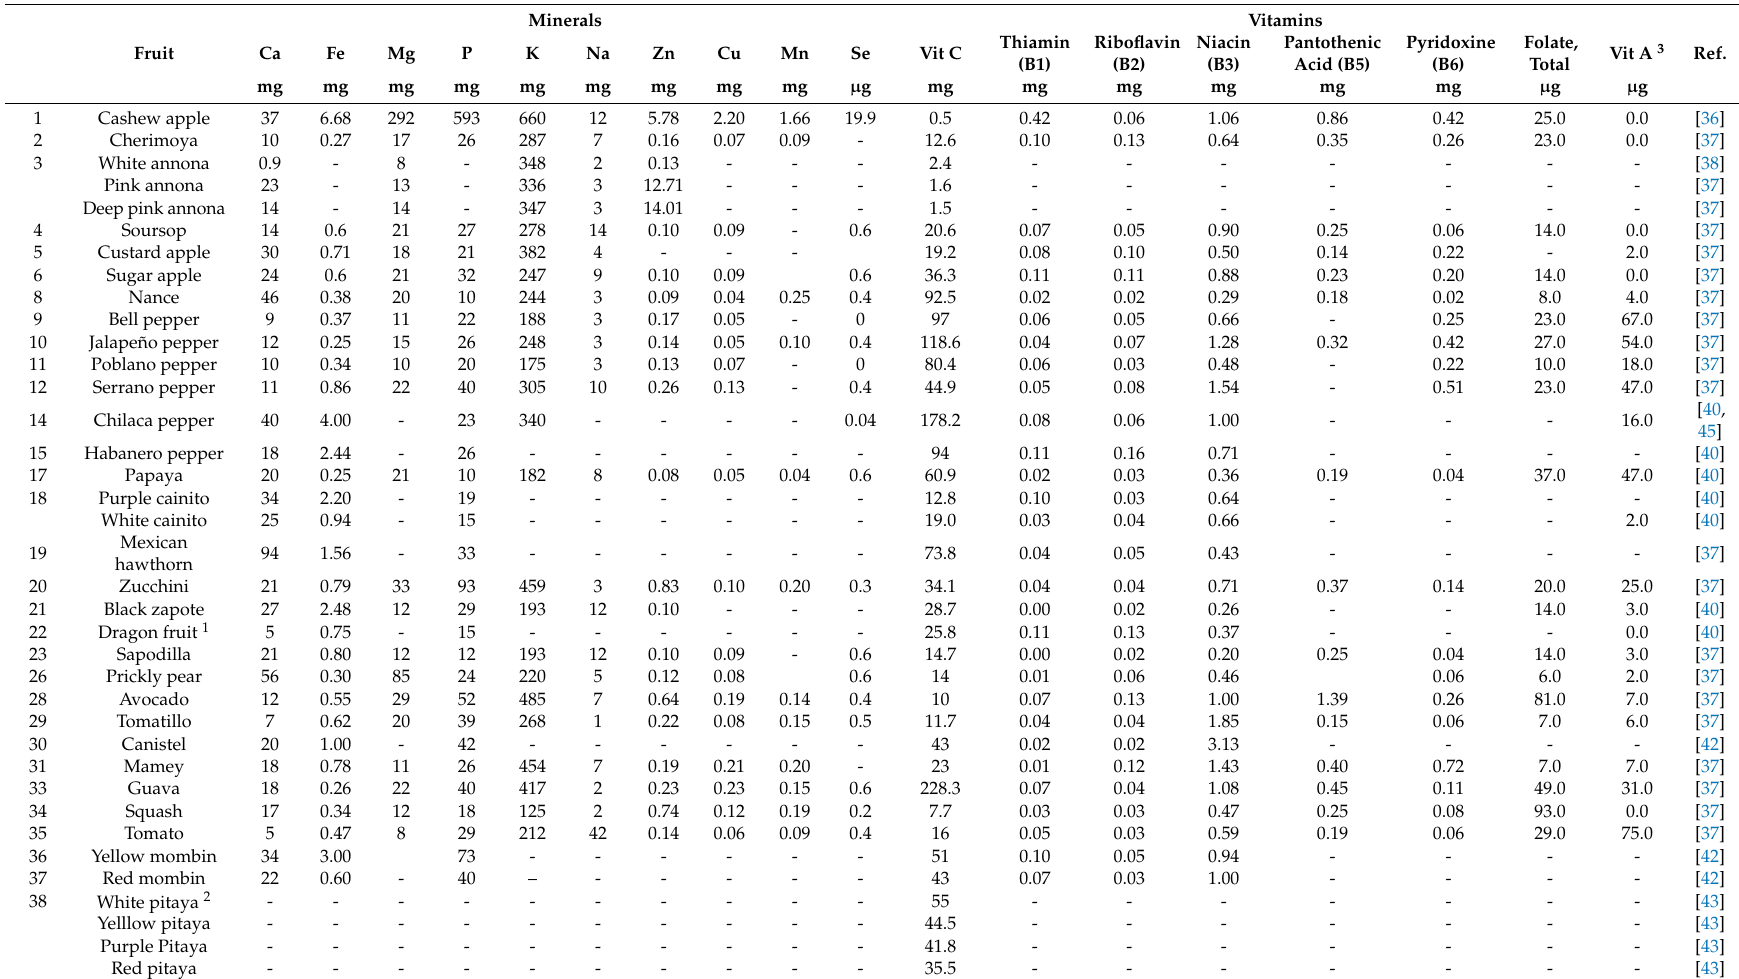
Table 3. Micronutrient composition (per 100 g) of Mesoamerican